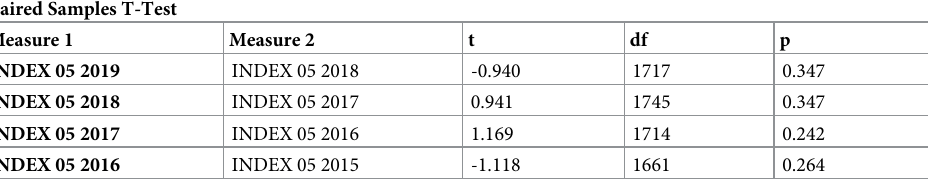
Table 6. Paired samples T-Test of INDEX 05. Paired Samples